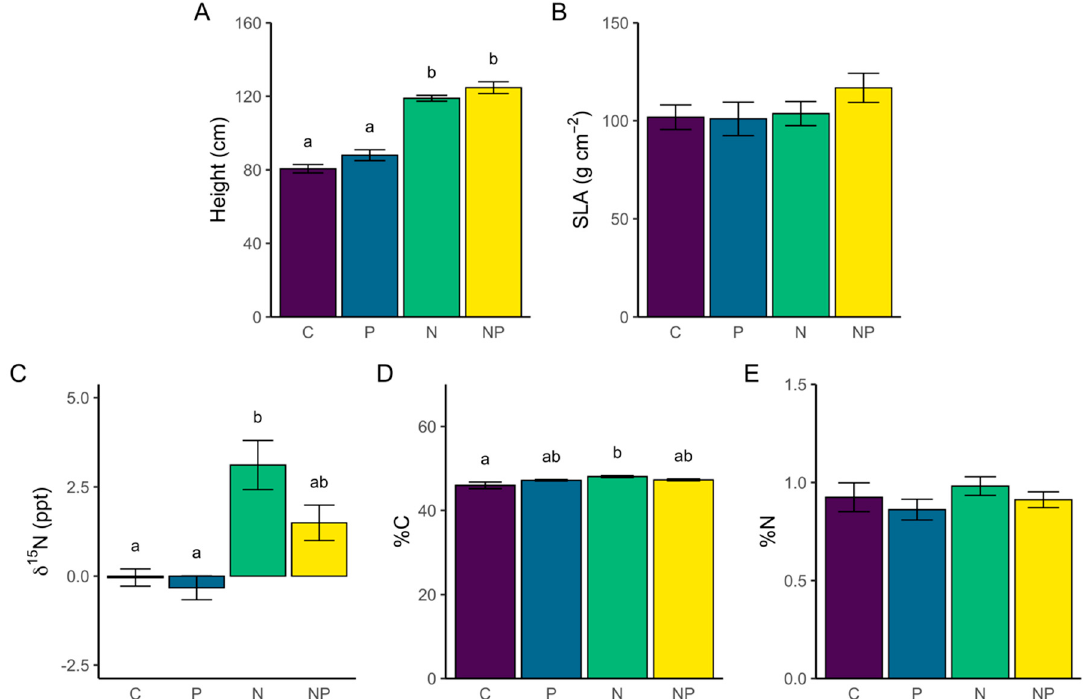
Figure 2. Mean ± SE of community-weighted height ( A ), specific leaf area ( B ), leaf nitrogen isotope ratio ( C ), leaf carbon content ( D ), and leaf nitrogen content ( E ) for each nutrient treatment (C = control, P = phosphorus, N = nitrogen, and NP = nitrogen + phosphorus) on a barrier island grassland community. Connecting letters indicate significant differences based on Tukey HSD pairwise comparison results. Bars that do not share the same letter are significantly different ( p < 0.05).